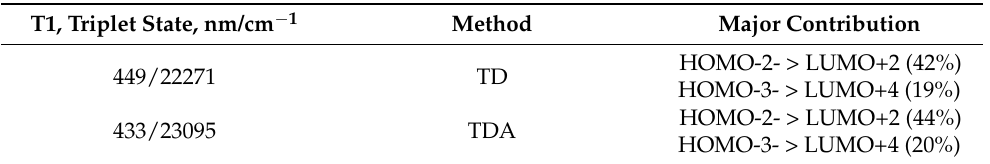
Table 1. The calculated energies of the first excited triplet state (T 1 ) calculated for Nd1 complex with the 6-311+G(d,p) basis set.